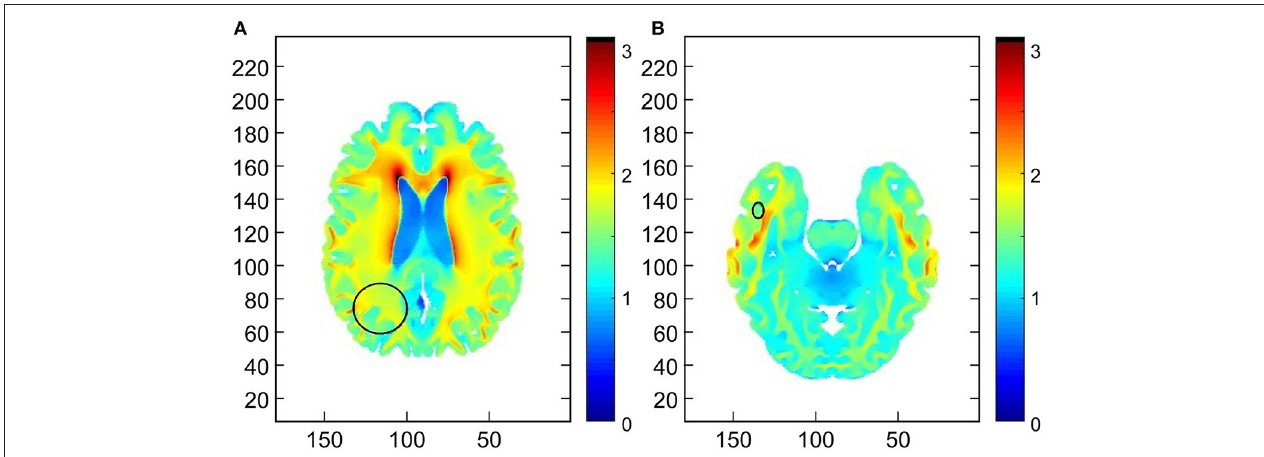
FIGURE 4 | Demonstration of the field intensity distribution in axial slices through the centers of the (A) primary right parietal lobe lesion and (B) the right temporal lobe secondary lesion. The median field intensity in the region of the primary lesion was 1.7 V/cm (mean of 1.66 V/cm). In the region of the secondary lesion the median intensity was 1.48 V/cm (mean of 1.56 V/cm). This suggests that TTFields intensities around both lesions exceeded the therapeutic threshold of 1 V/cm.